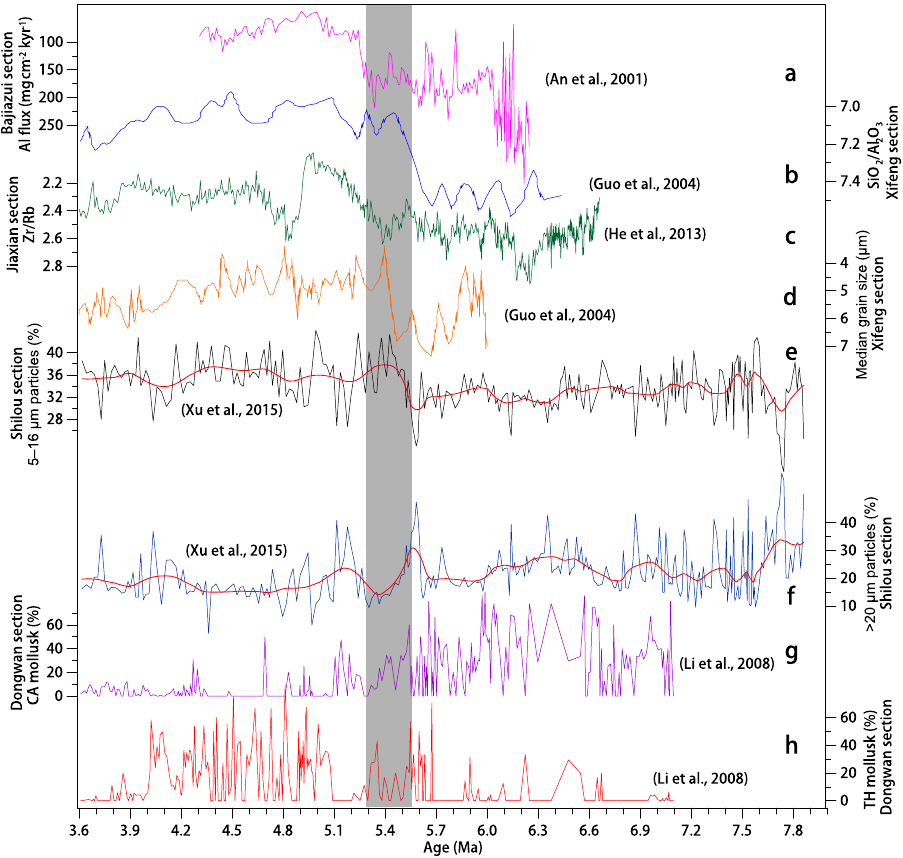
Fig. 5 Chinese Loess Plateau red clay records of climate variability. a Al fl ux at the Bajiazui section 17 . b SiO 2 /Al 2 O 3 from the Xifeng section 20 . c Zr/Rb from the Jiaxian red clay section 26 . d Median grain size from the Xifeng section 20 . e , f Fine (5 – 16 μ m) and coarse (>20 μ m) particle concentration from the Shilou section 56 . Red smooth curves are fi tted using the MatLab LOWESS function. g , h Cold-aridiphilous (CA) and thermo-humidiphilous (TH) terrestrial mollusk changes in the Dongwan red clay 57 (Fig. 6f – g) and increased lower-tropospheric water vapour load-